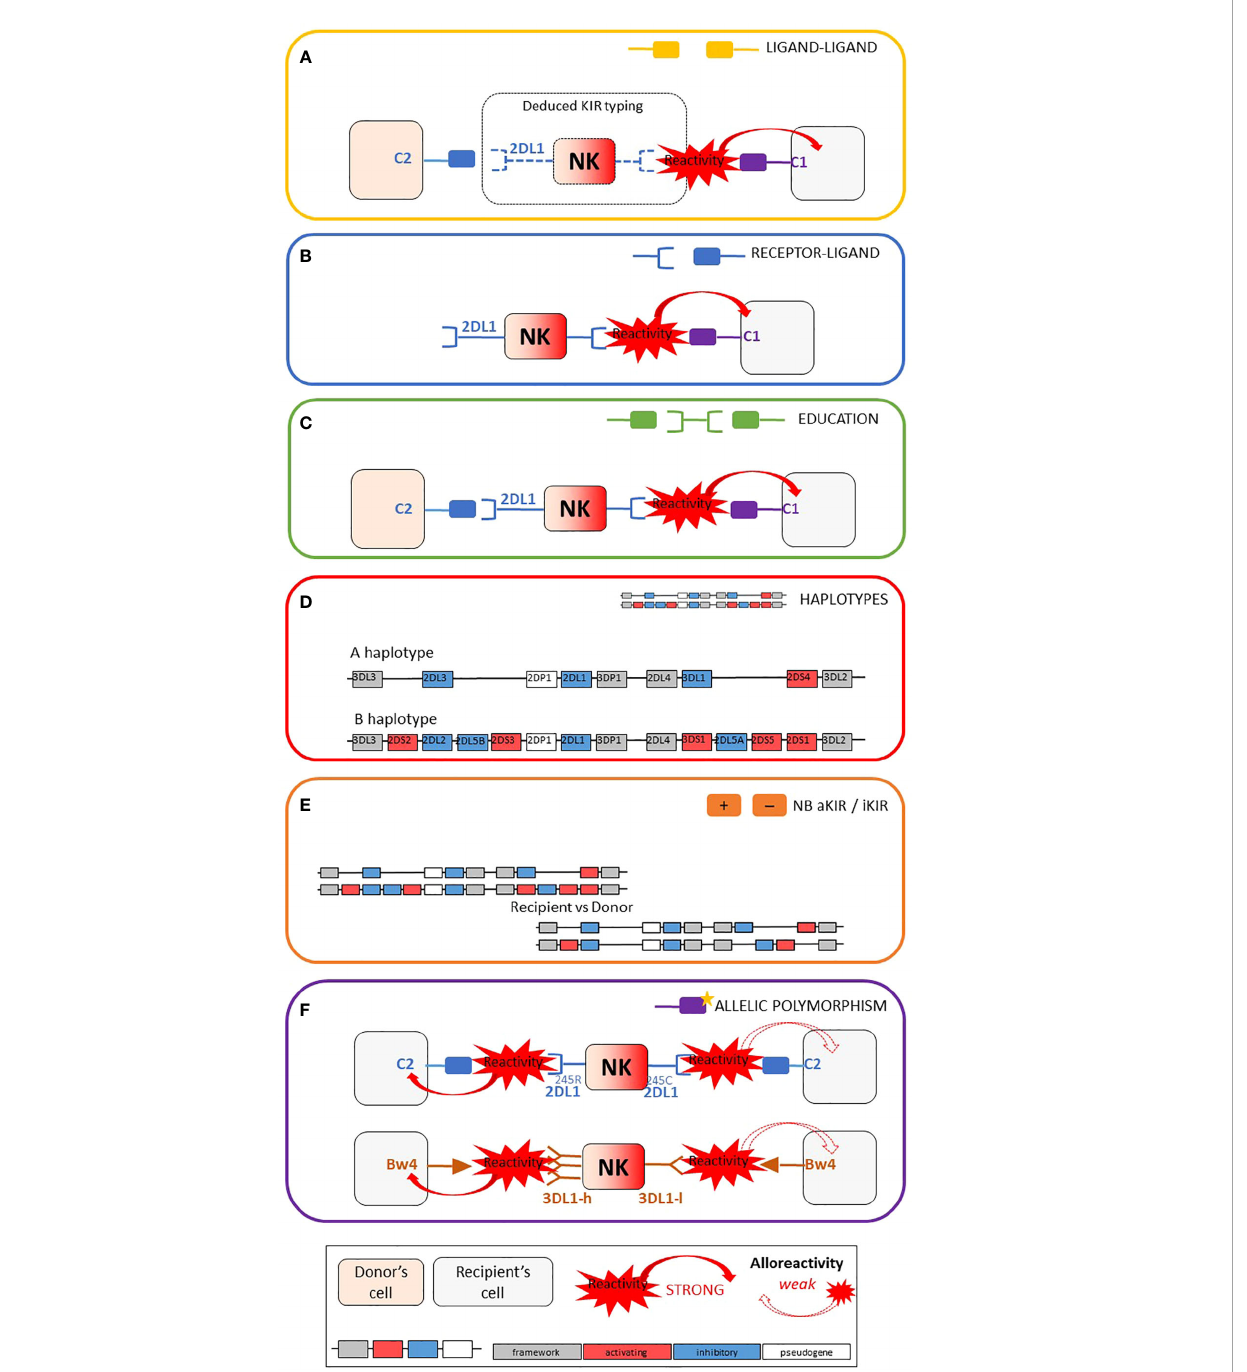
FIGURE 1 Schematic representation of the six main categories of models used for NK alloreactivity prediction and summary table of the characteristics of each category. Adapted from Dhuyser et al. (16). (A) Ligand – ligand model confronts the MHC of the donor with the MHC of the recipient: KIR genotyping is unknown and NK alloreactivity of the donor toward host cells is expected when the recipient lacks MHC class I ligand present in the donor. (B) Receptor – ligand model considers the KIR of the donor and the MHC of the recipient: if at least one KIR gene expressed in the donor does not recognize any of the MHC molecules of the recipient ( “ missing-ligand ” ), the NK cells of the donor will increase their cytotoxic activity. (C) Educational models consider the MHC class I molecules of the donor and recipient and the KIR typing of the donor. It should re fl ect the “ education ” process required for NK cells to become competent. (D) The KIR haplotypes of the donor: the B/x of the donor and particularly those carrying Cen-B/B are expected to be more alloreactive toward the cell of the recipients, as they carry mostly activating KIR genes. (E) KIR matching models represent the number of aKIR and/or iKIR gene present in the donor but absent in the recipient and vice versa. (F) KIR polymorphism leads to KIR molecules with relevant biological